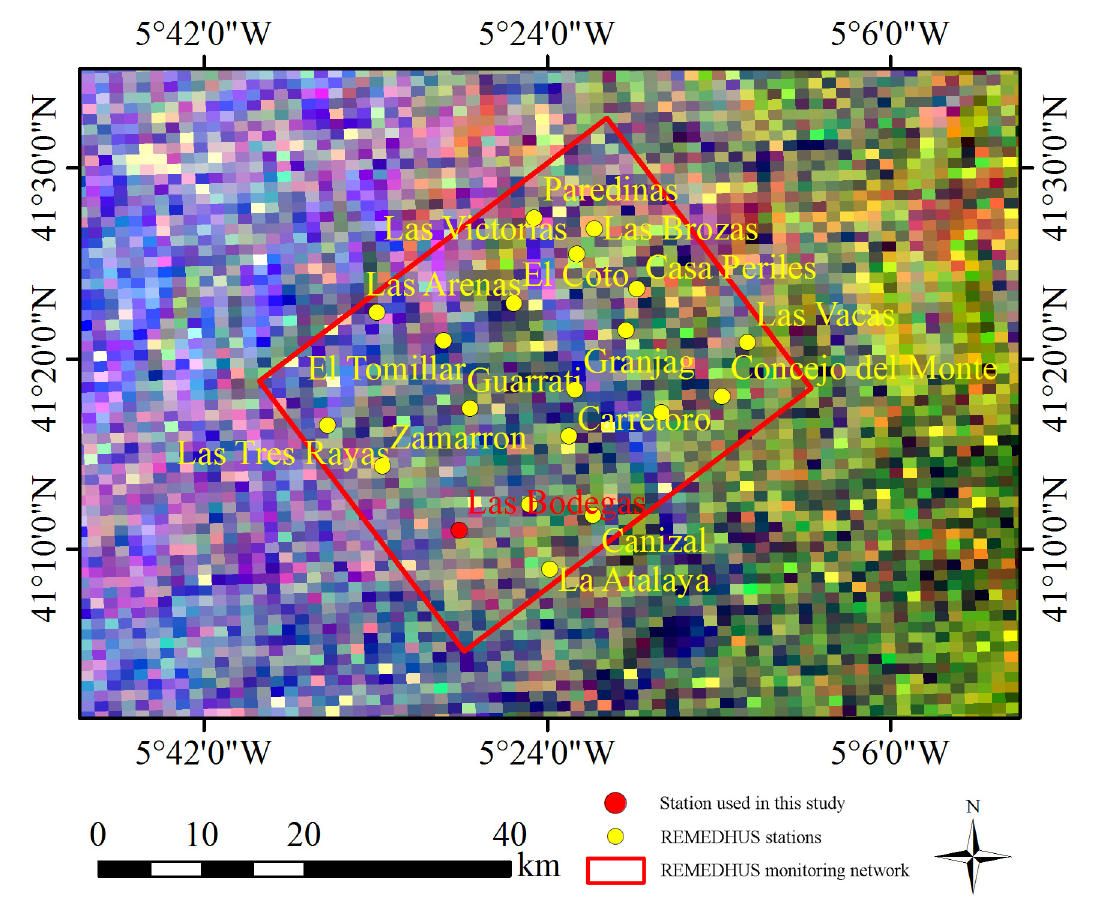
Figure 1. Location of the REMEDHUS network.